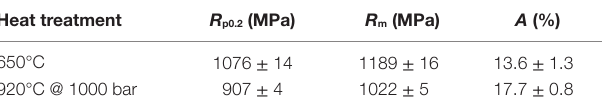
TaBle 1 | static mechanical properties of laser additive manufactured Ti–al6–4V.